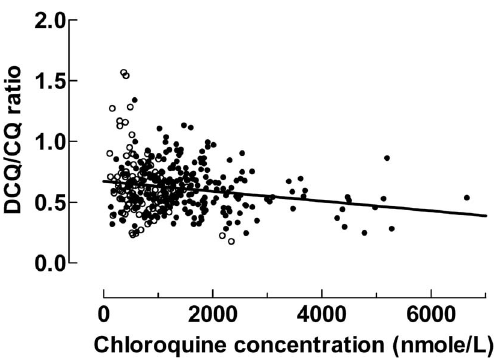
Figure 2. Chloroquine concentrations normalised for mg/kg. The dose normalised CQ concentrations increases with increasing age (p , 0.001). The solid line is given by linear regression.